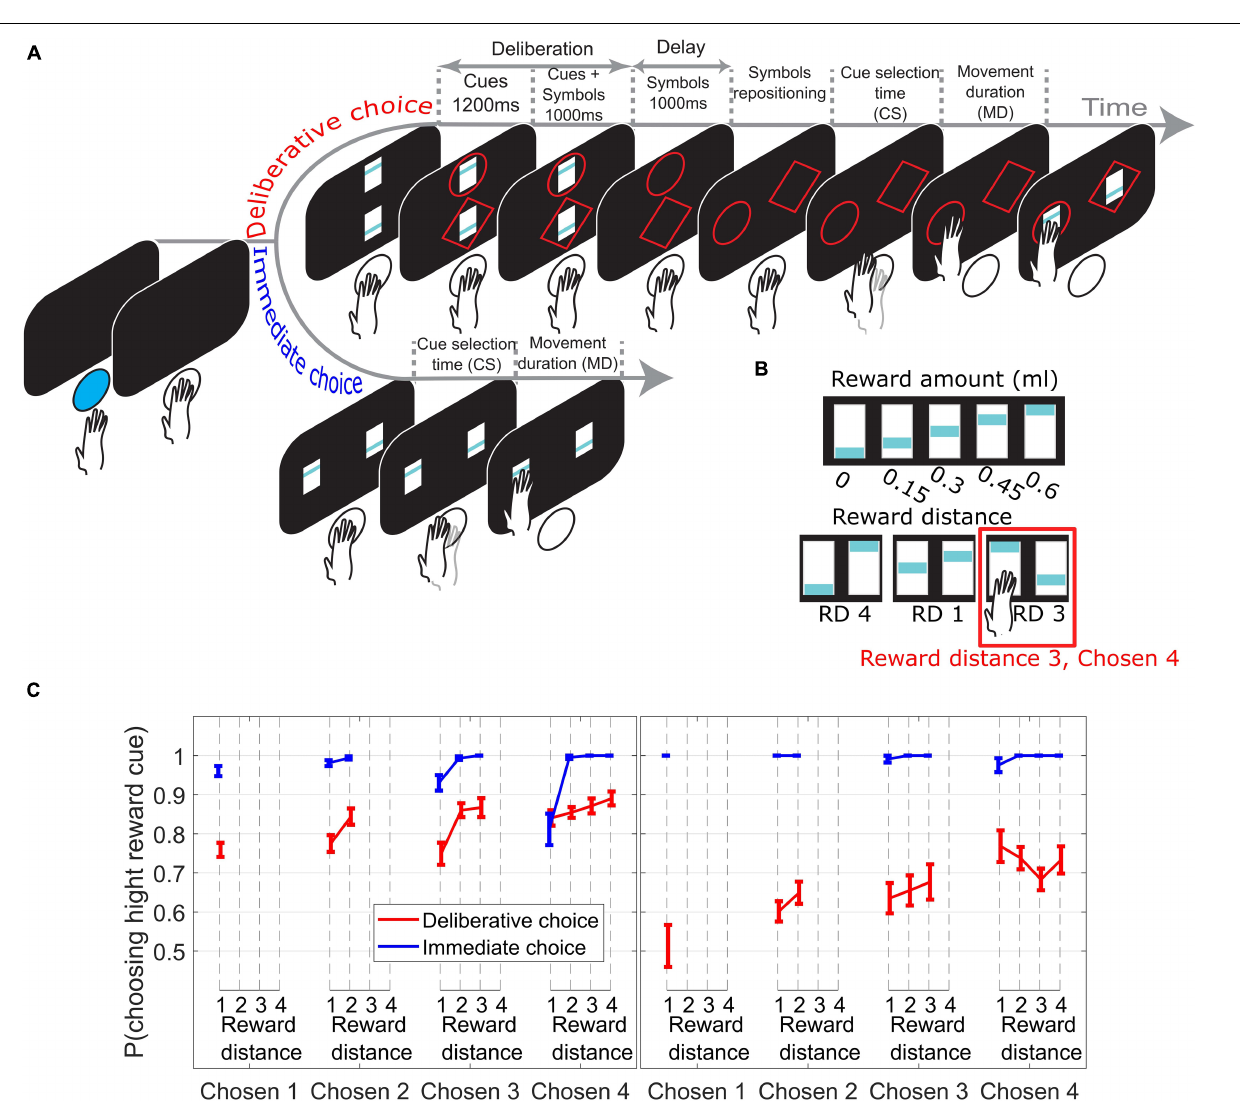
FIGURE 1 | (A) Subjects initiated a trial by pushing a blue led button. In DC trials (top timeline) two reward cues appeared, with the offer magnitudes 0–4 units of juice reward signaled by the blue bar height. Next, a circle or a diamond (response-symbol) was randomly assigned and added to each reward cue. Reward cues were removed during the delay period. Next, the response-symbols where repositioned randomly to the response locations allowing the subjects to reach for the symbol corresponding to their reward choice. The reward cue corresponding to the chosen symbol was shown for an additional 300 ms as visual feedback and reward was delivered. In IC trials (bottom timeline), subjects reached for the chosen reward cue as soon as it appeared. (B) Upper row shows the reward cues used with their corresponding amount of juice reward. Lower row shows 3 example trials with the corresponding reward distance (RD) between cues. (C) Choice performance across sessions ( ± SEM) as function of reward distance between the choice offer cues for different Chosen Values. Left/right panel from